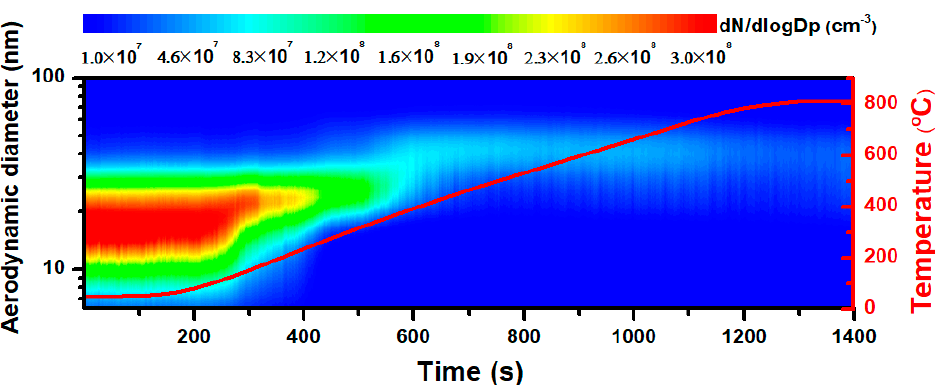
Figure 2. Size and time-resolved particle number concentration during heating from room temperature (RT) to 800 °C. The red line represents the furnace temperature.